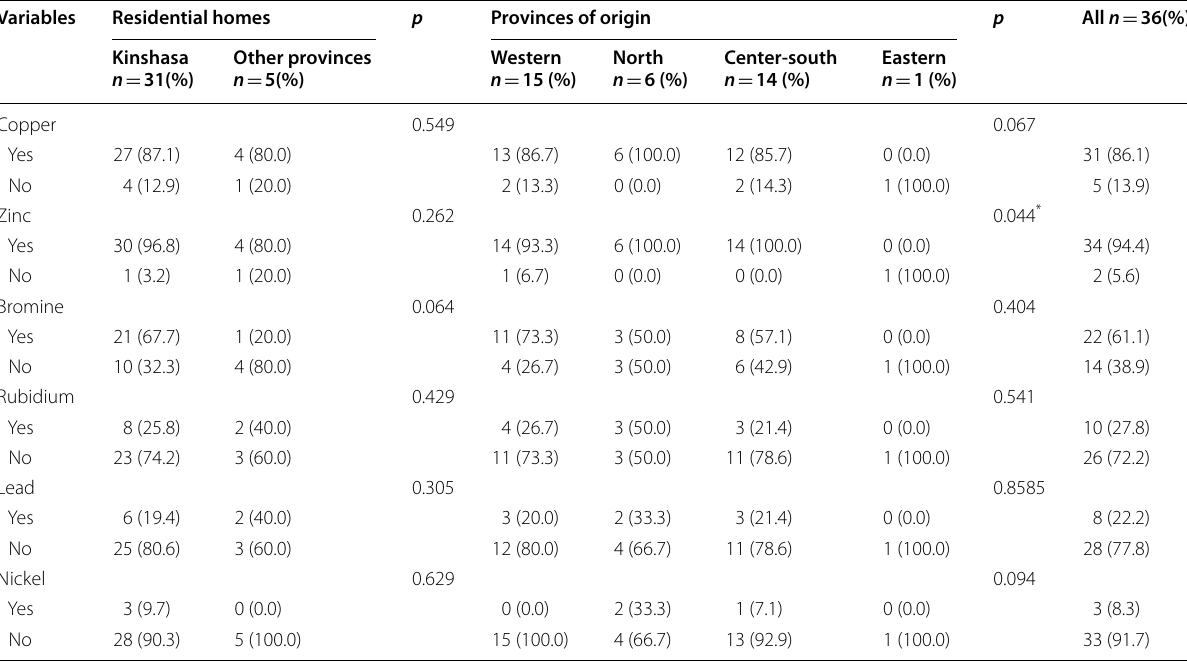
* Likelihood ratio chi-square